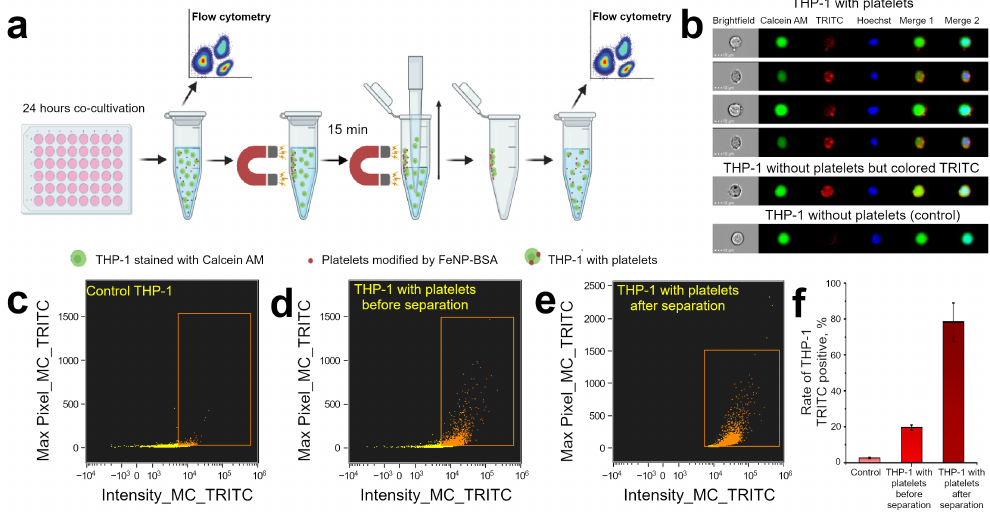
Figure 6. ( a ) Schematic representation of the experimental procedure in study of THP-1 cells subpop- ulations during co-cultivation with platelets modified with magnetite nanoparticles. ( b ) Examples of THP-1 in cell population (Calcein AM channel corresponds to THP-1 cytoplasm, TRITC channel corresponds to platelets, Hoechst stained the THP-1 nuclei, Merge 1 is overlapping of Calcein AM and TRITC channels, Merge 2 joined all fluorescence channels). ( c – e ) Bivariate scatterplots defined total TRITC intensity and presence of bright spots in ( c ) control samples without platelets co-cultivation, ( d ) experimental sample with co-cultivation before and ( e ) after magnetic separation. The boxed area defines a population with intense TRITC fluorescence provided by exogenous dyes characteristic for platelets in this experiment. ( f ) Percentage of THP-1 associated with TRITC